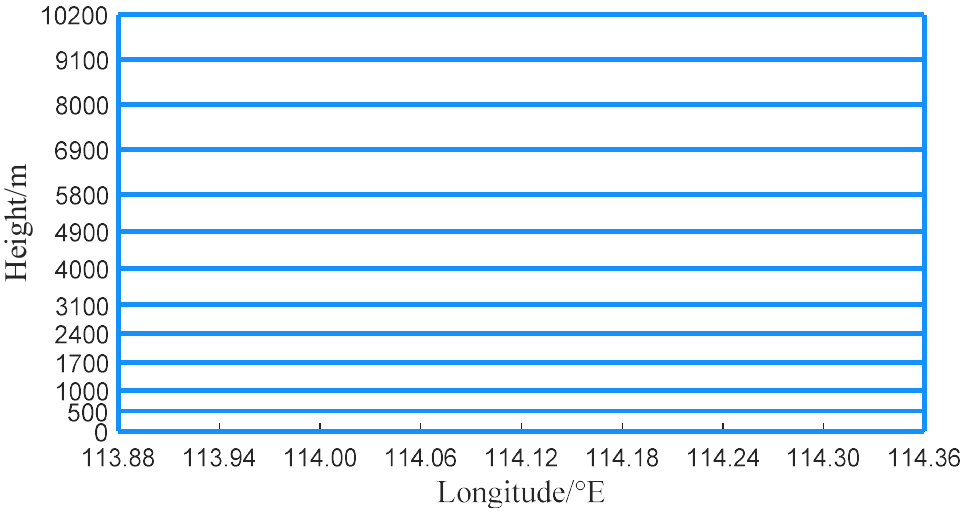
Figure 7. Vertical grid strategy in the study area. The troposphere over HK was divided into 12 layers from bottom to top with thicknesses of 0.5, 0.5, 0.7, 0.7, 0.7, 0.9, 0.9, 0.9, 1.1, 1.1 1.1, and 1.1 km.